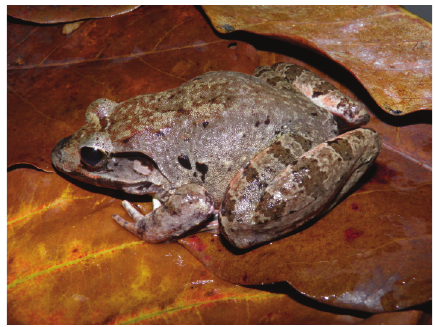
Figure 3: Crouching behaviour exhibited by L. blythii